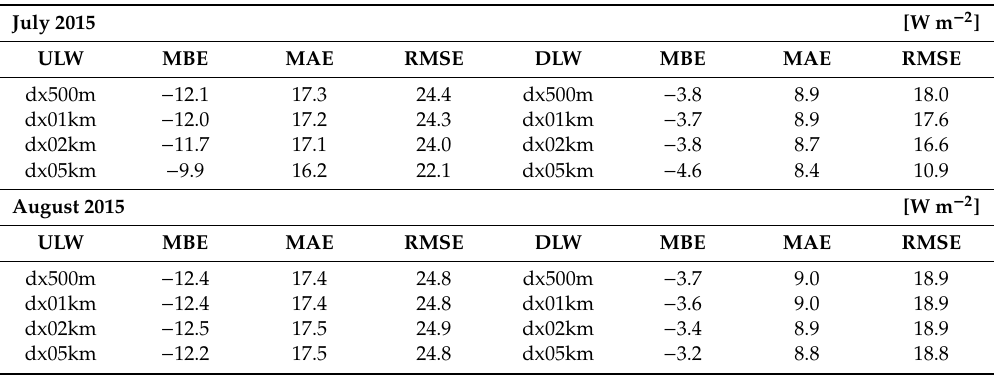
Table 4. Forecast error metrics (MBE, MAE, and RMSE) for ULW and DLW with the four di ff erent horizontal resolutions for the Exp-Summer (July (upper tables) and August (lower tables)) in 2015. The forecast uses a 00 UTC (09 JST) initialization